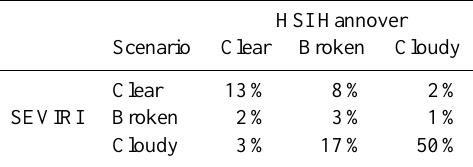
fer to Table 3: 100 % − a − e − i ). In 74 % of these cases these differences will occur during cloud-contaminated sky ( (b + h)/ 33